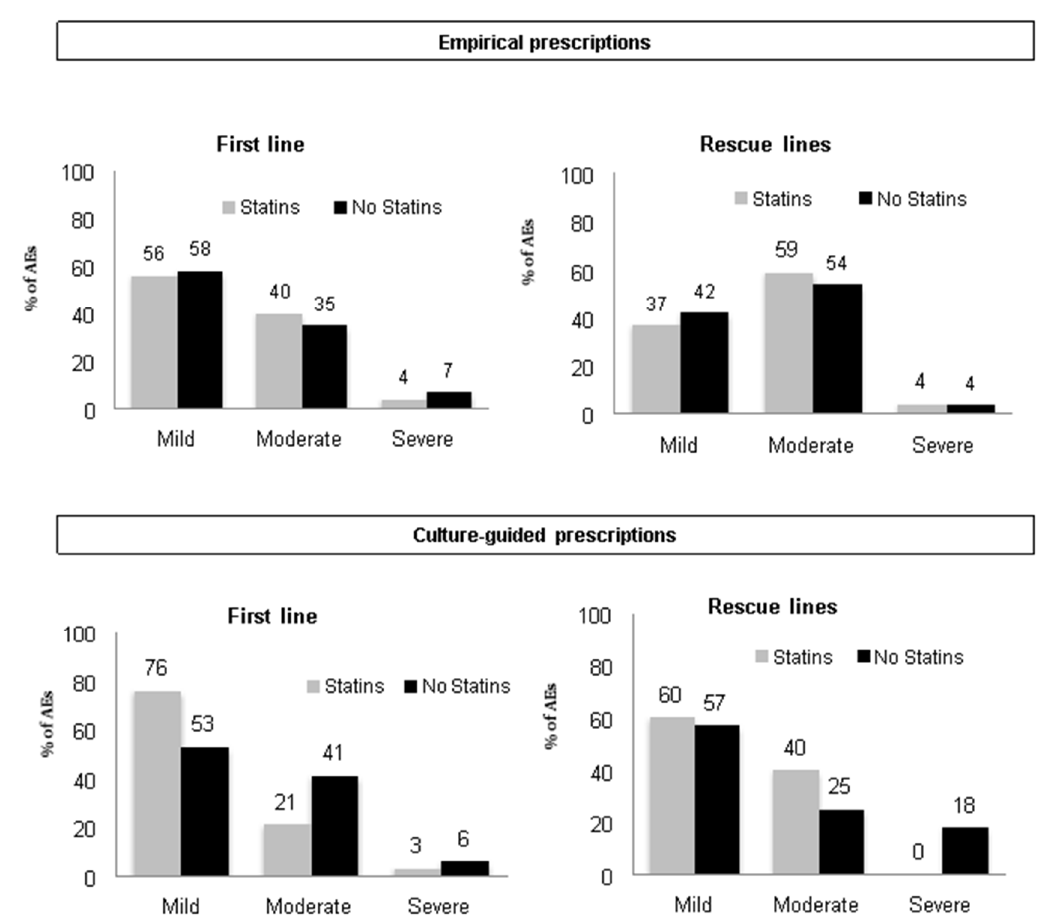
Figure 3. Distribution of adverse event severity presented according to statin use and treatment line.